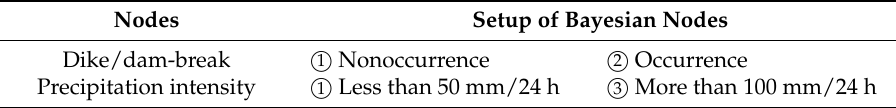
Table 4. The setup of states combination of dike/dam-break flooding case and other comparative cases. Nodes Setup of Bayesian Nodes